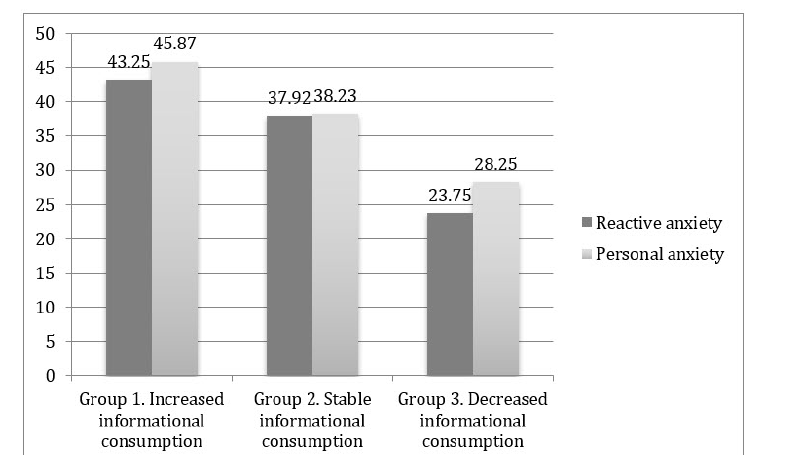
Figure 3. Level of reactive and personal anxiety in groups with different informational consumption The level of anxiety is the highest in Group 1. The average scores in Group 3 are the lowest in the sample. Group 2 showed medium results. In all experimental groups the level of personal anxiety is insignificantly higher than situational anxiety.